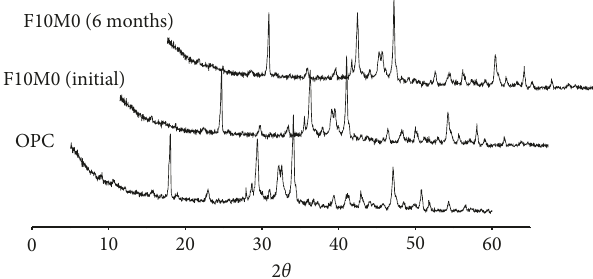
Figure 2: XRD graph for the semi premix paste after 3